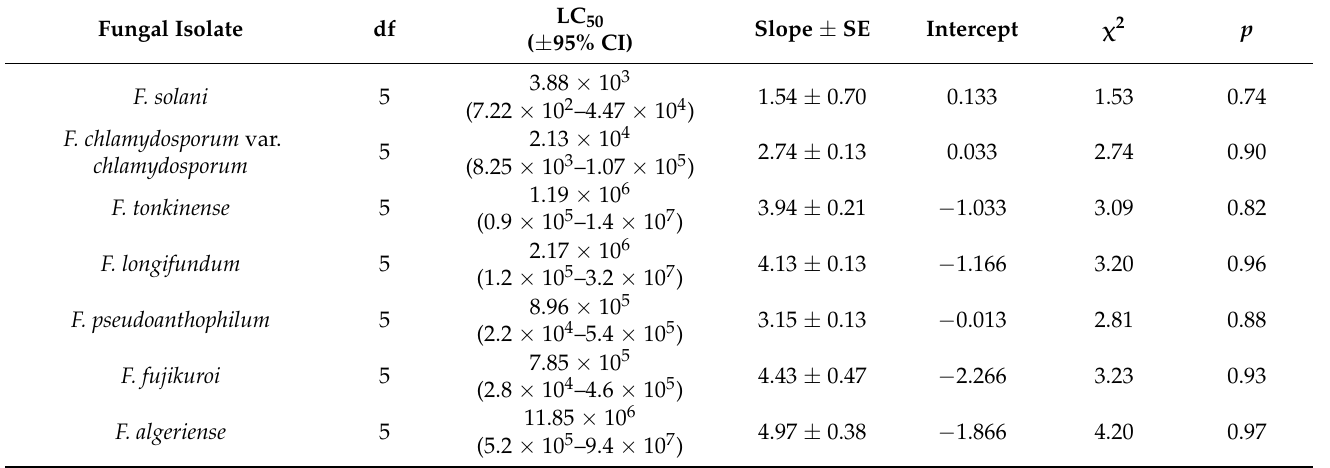
Table 10. Estimated lethal concentrations (LC 50 ) for Fusarium species on 3rd-instar larvae of H. armigera . LC : lethal concentrations; CI : confidence limit; SE : standard error; χ 2 : Chi-squared goodness of fit test, LC values are considered significantly different when 95% confidence limits fail to